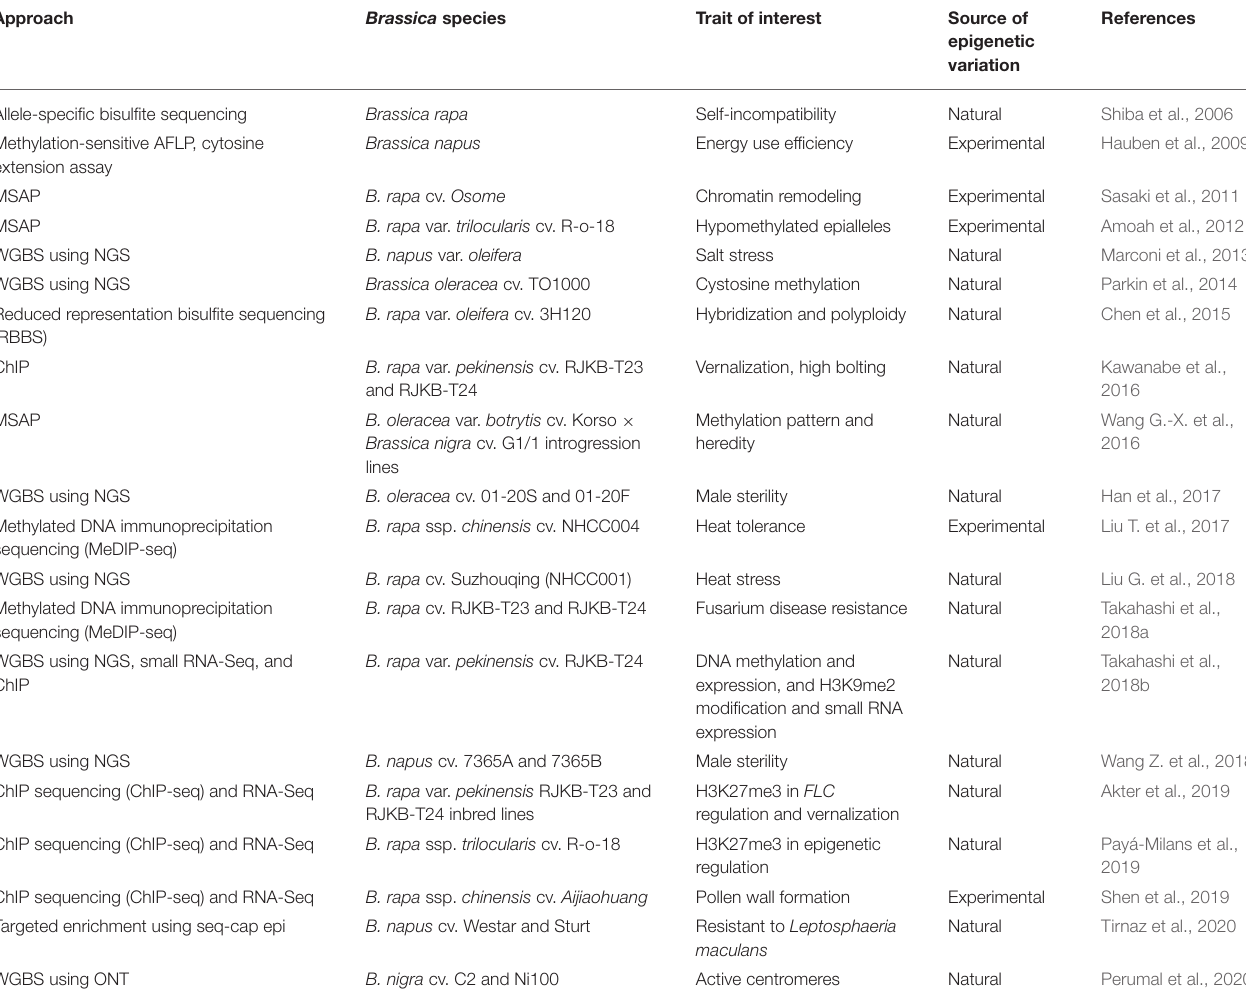
TABLE 3 | Exploration of epigenetic resources in Brassica for natural and experimentally induced